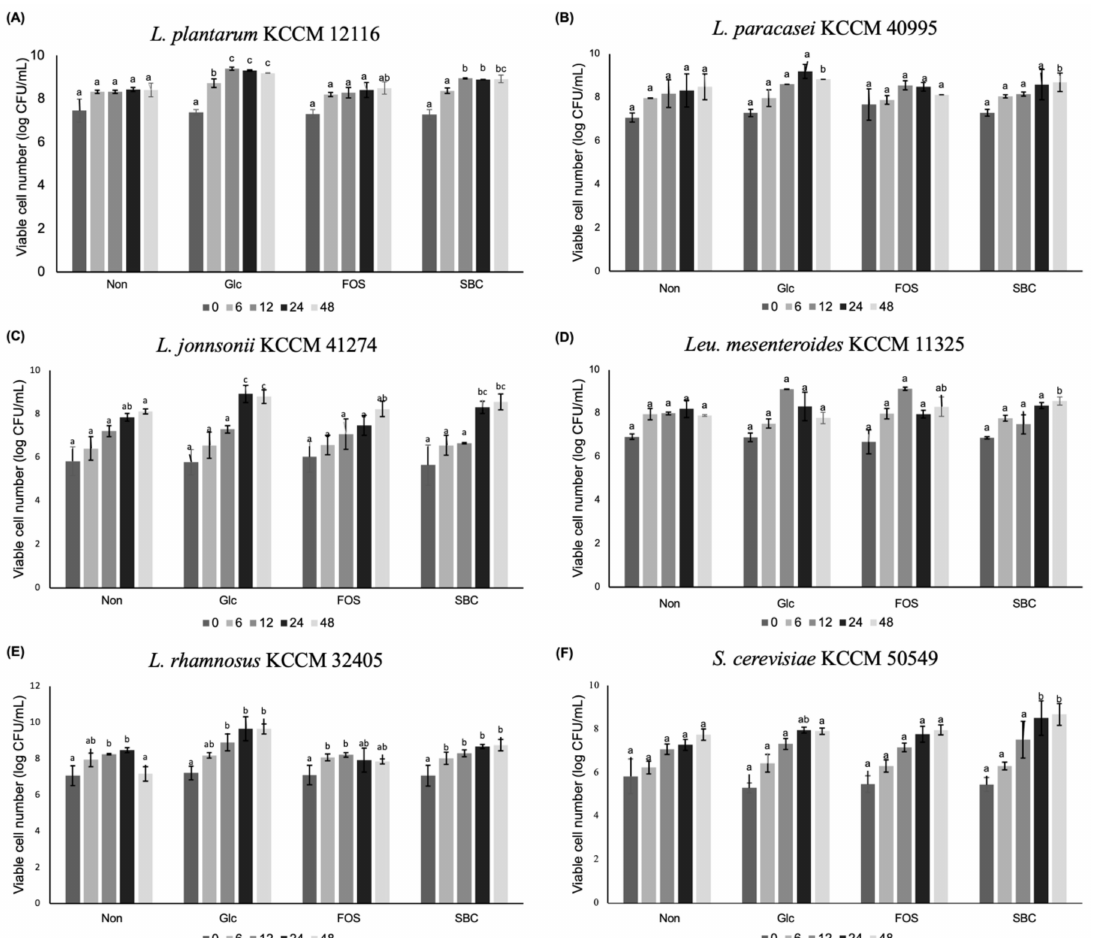
Figure 5. Prebiotic effects of the oligosaccharides produced by Leu. lactis SBC001 on bacterial and yeast strains. ( A ) L. plantarum KCCM 12116; ( B ) L. paracasei KCCM 40995; ( C ) L. johnsonii KCCM 41274; ( D ) Leu. mesenteroides KCCM 11325; ( E ) L. rhamnosus KCCM 32405; ( F ) S. cerevisiae KCCM 50549. Non, glucose-free medium; Glc, 1%( w / v ) glucose-containing medium; FOS, glucose-free medium supplemented with 1%( w / v ) FOS; SBC, glucose-free medium supplemented with 1%( w / v ) oligosaccharides produced by Leu. lactis SBC001. Different letters among groups represent statistically significant differences ( p < 0.05). 0, 6, 12, 24, and 48, mean incubation time (h) of bacterial and yeast